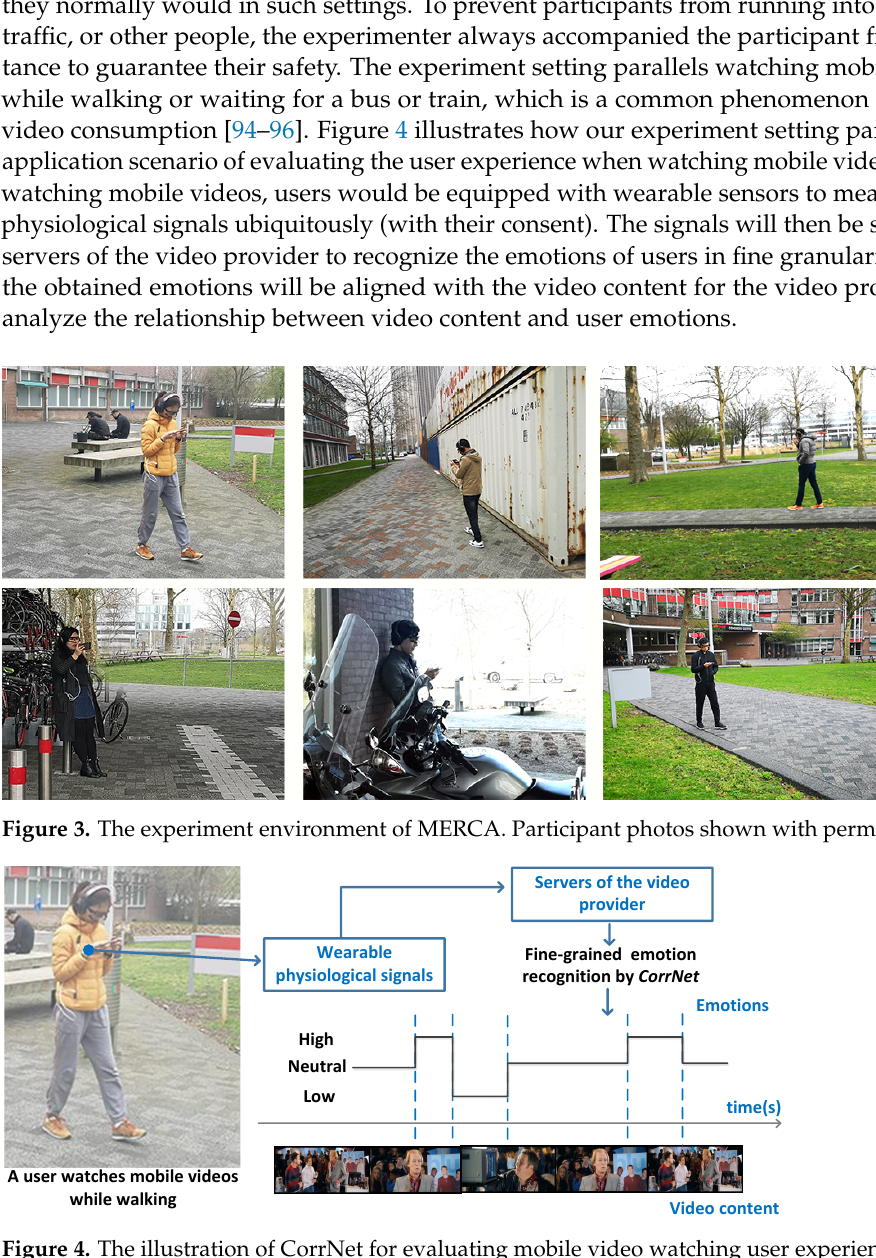
Figure 4. The illustration of CorrNet for evaluating mobile video watching user